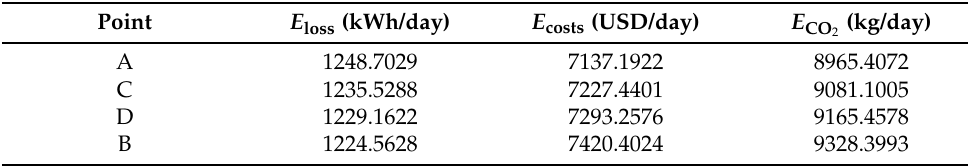
The numerical results in Table 5 show